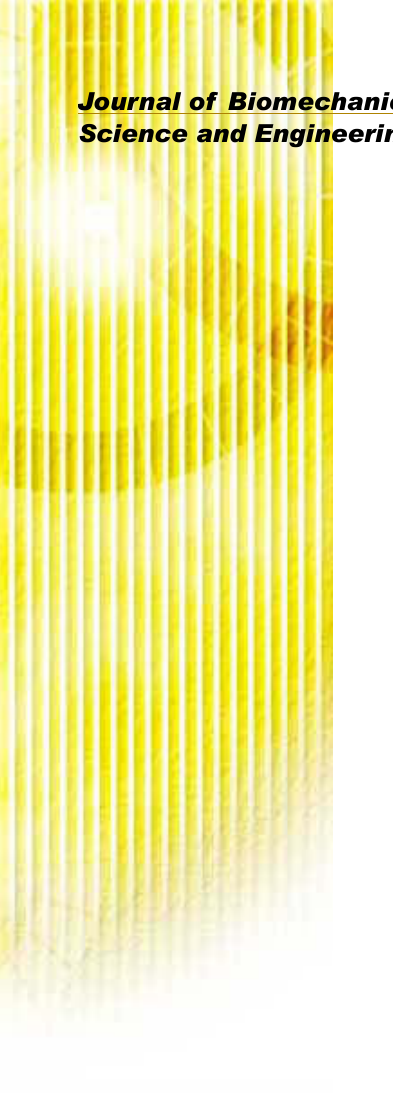
Fig 7. Comparison of ROM according to ball head diameter.